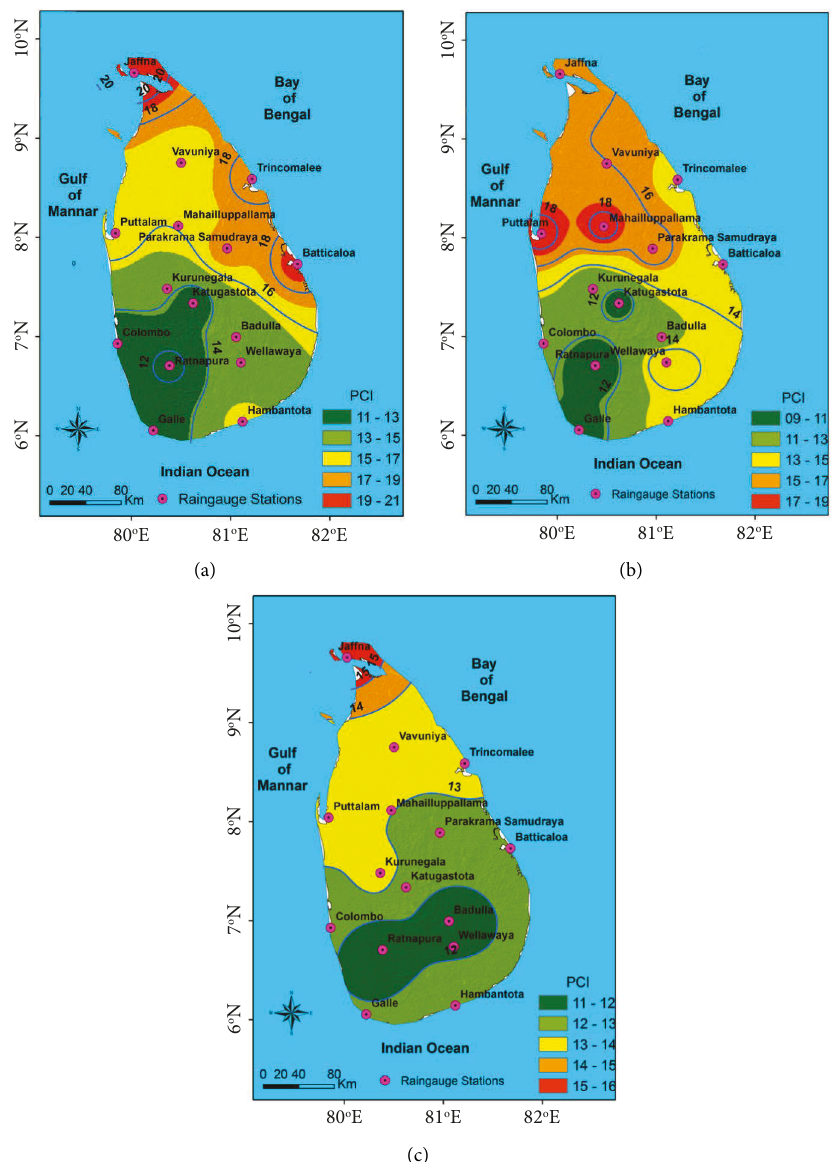
Figure 5: Spatial distribution of mean annual and seasonal PCI in Sri Lanka. (a) For annual PCI. (b) For SWM PCI. (c) For NEM